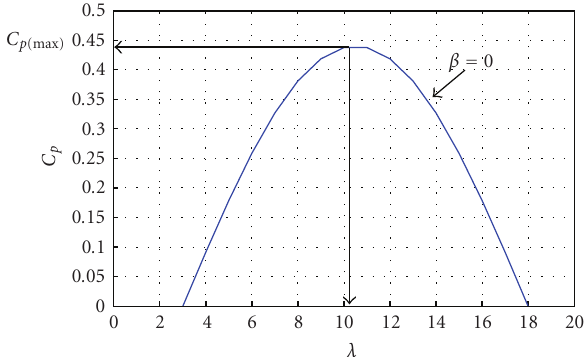
Figure 2: Power coe ffi cient C p versus TSR λ .